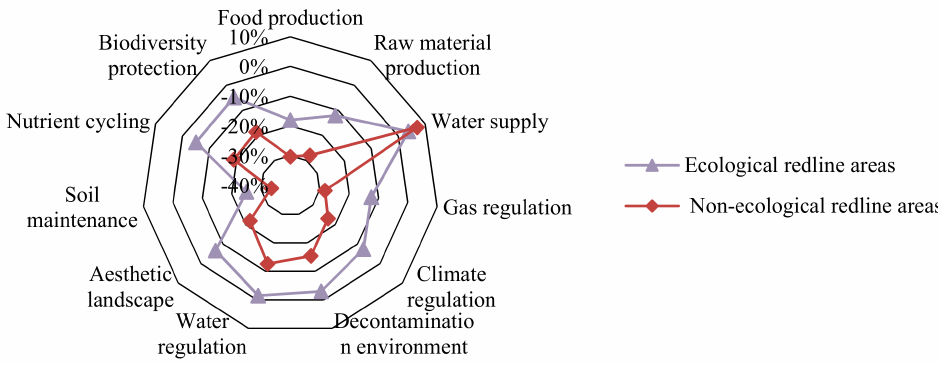
Figure 6. Change rate of ecosystem service value in ecological and non-ecological redline areas during